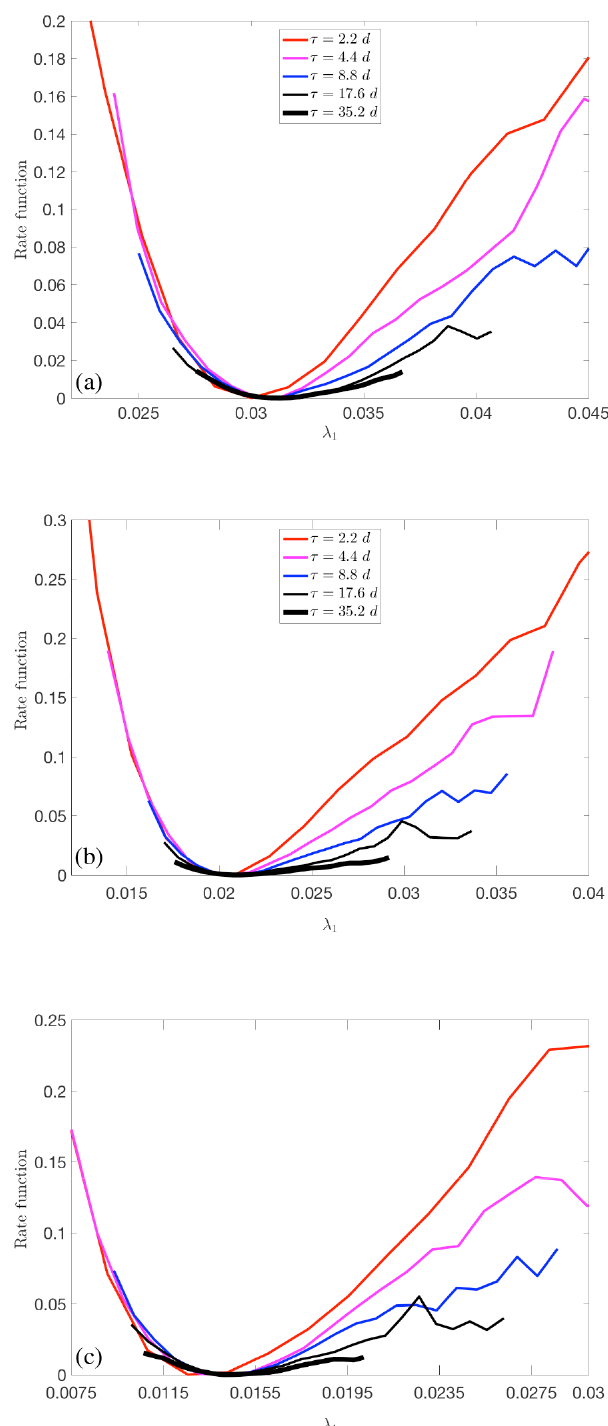
Figure 21. Estimate of the rate function describing the large devi- ation law of the first FTLE for MAOOAM with no dissipation (a) , reference value for the dissipation (b) , and enhanced dissipation by a factor of 10 (c)